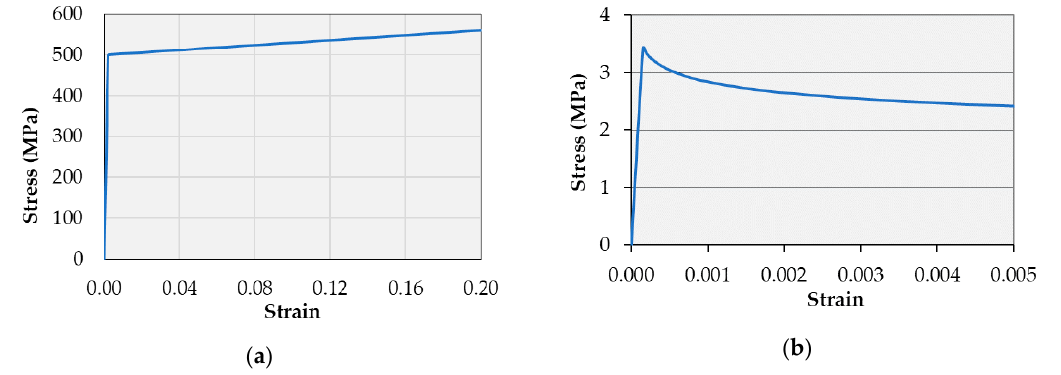
Figure 9. Stress–strain diagram for: ( a ) steel reinforcement; ( b ) concrete in tension.